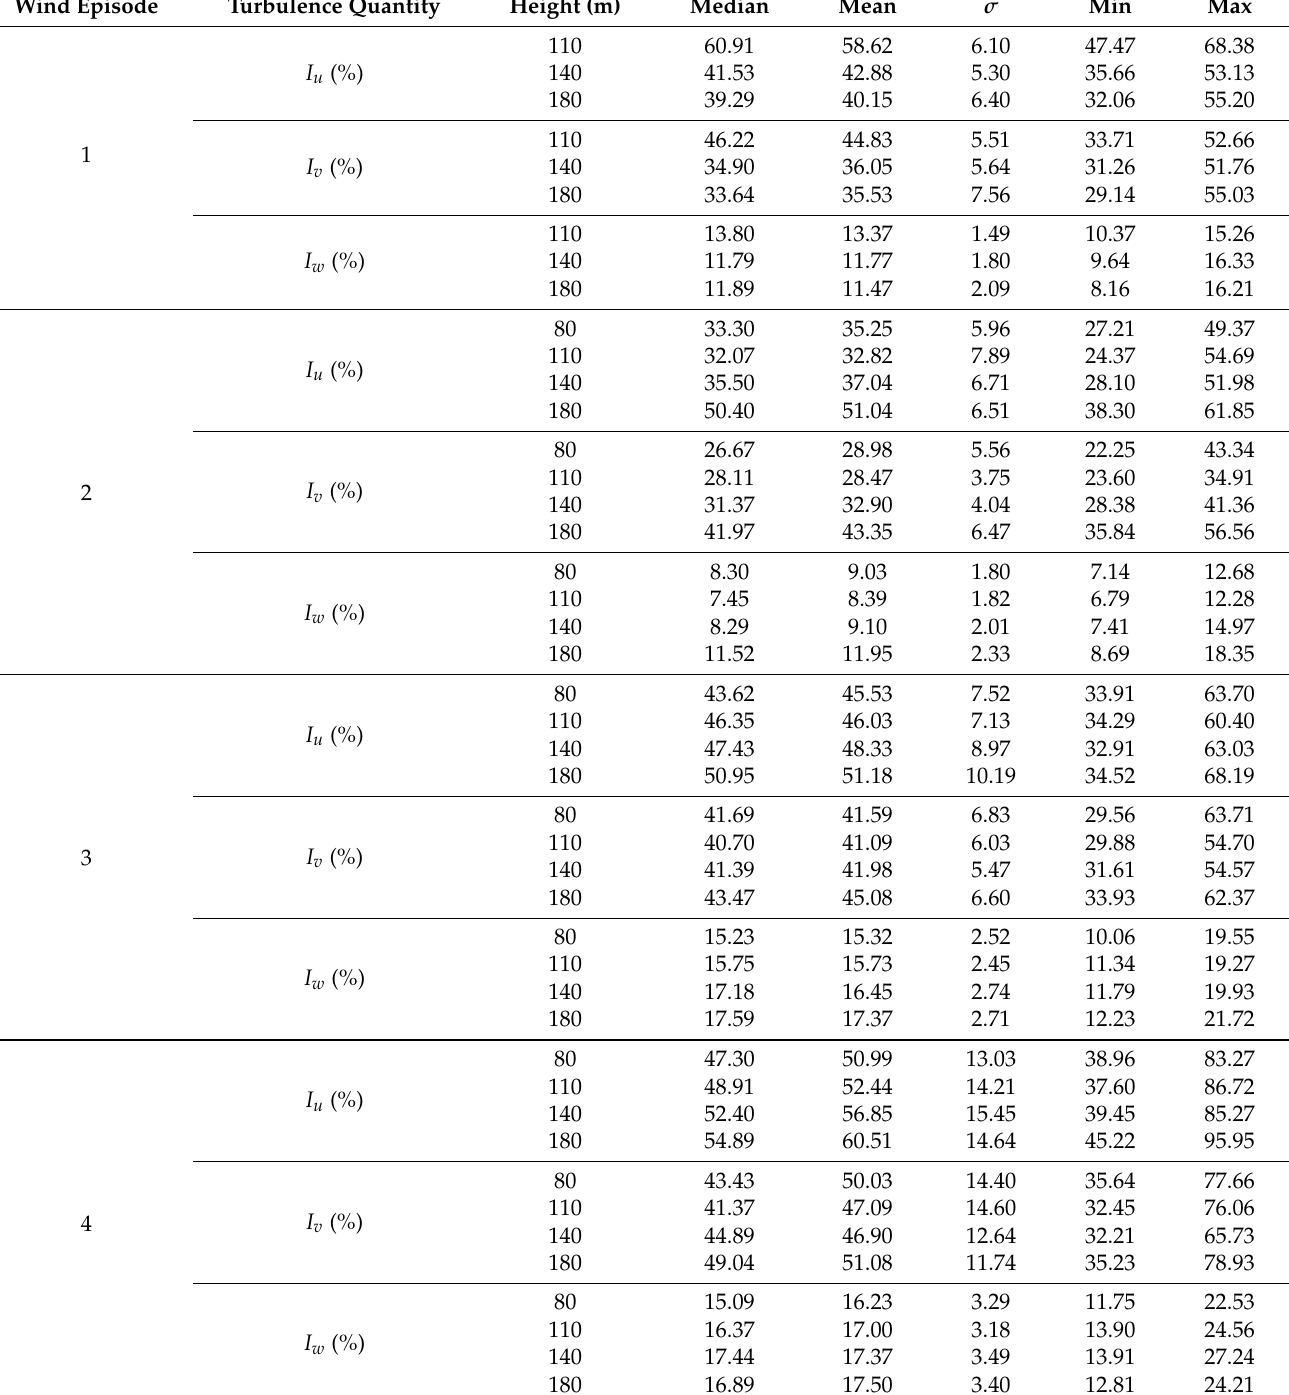
Table A1. Main characteristics of turbulence intensity in the along-wind, lateral and vertical direction: median, mean, standard deviation ( σ ), minimum and maximum values at four different heights are given for eight wind episodes. Wind Episode Turbulence Quantity Height